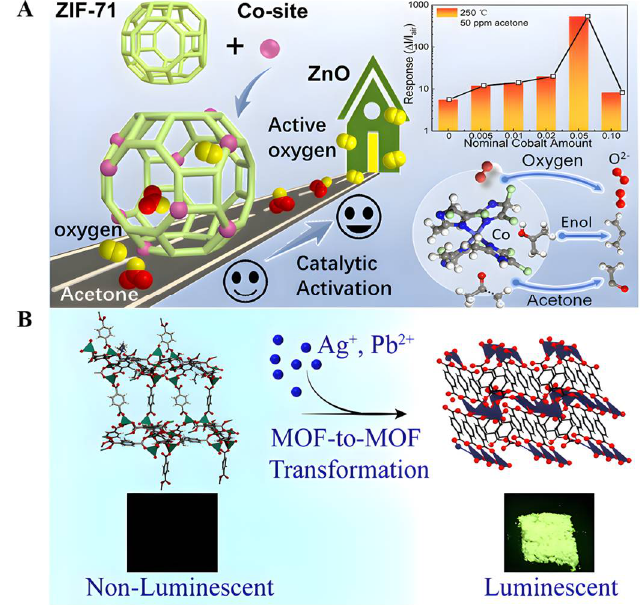
Figure 3. ( A ) Schematic illustration of the catalytic gas-sensing mechanism in ZnO@ZIF-71(Co) with active Co sites. Reproduced with permission [86]. Copyright 2020, ACS applied materials & interfaces . ( B ) Facile and fast transformation of nonluminescent to highly luminescent metal–organic frame- works. Reproduced with permission [56]. Copyright 2021, ACS Applied Materials & Interfaces